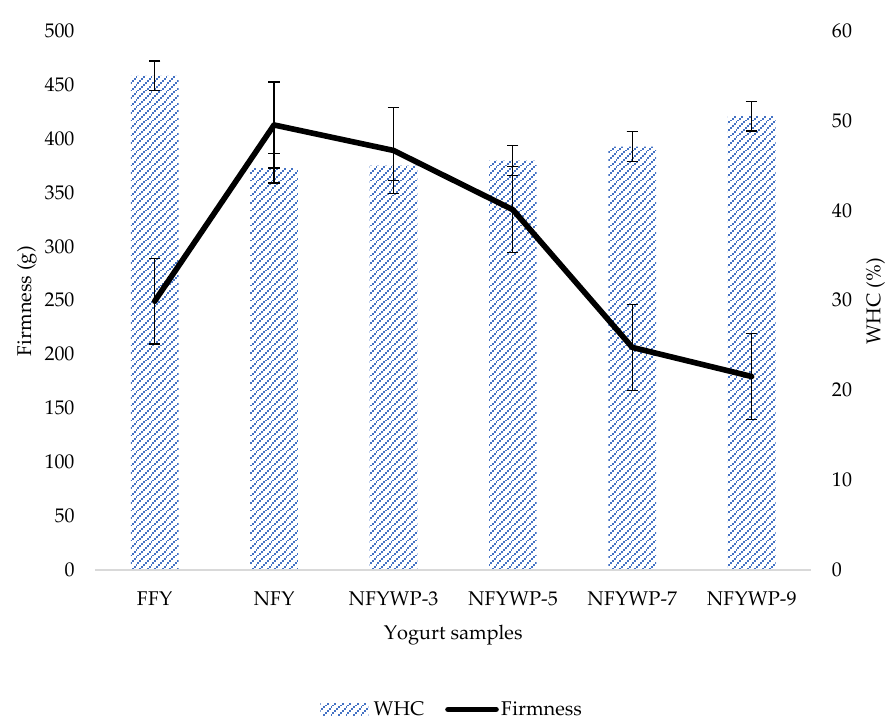
Figure 1. The firmness (g) and water holding capacity (WHC) of yogurt samples. FFY = full-fat yogurt produced from whole milk powder (WMP); NFY = non-fat yogurt produced from skim milk powder (SMP); NFYWPI-3 = SMP was replaced by 3% WPI; NFYWP-5 = SMP was replaced by 5% WPI; NFYWP-7 = SMP was replaced by 7% WPI; NFYWP-9 = SMP was replaced by 9% WPI.